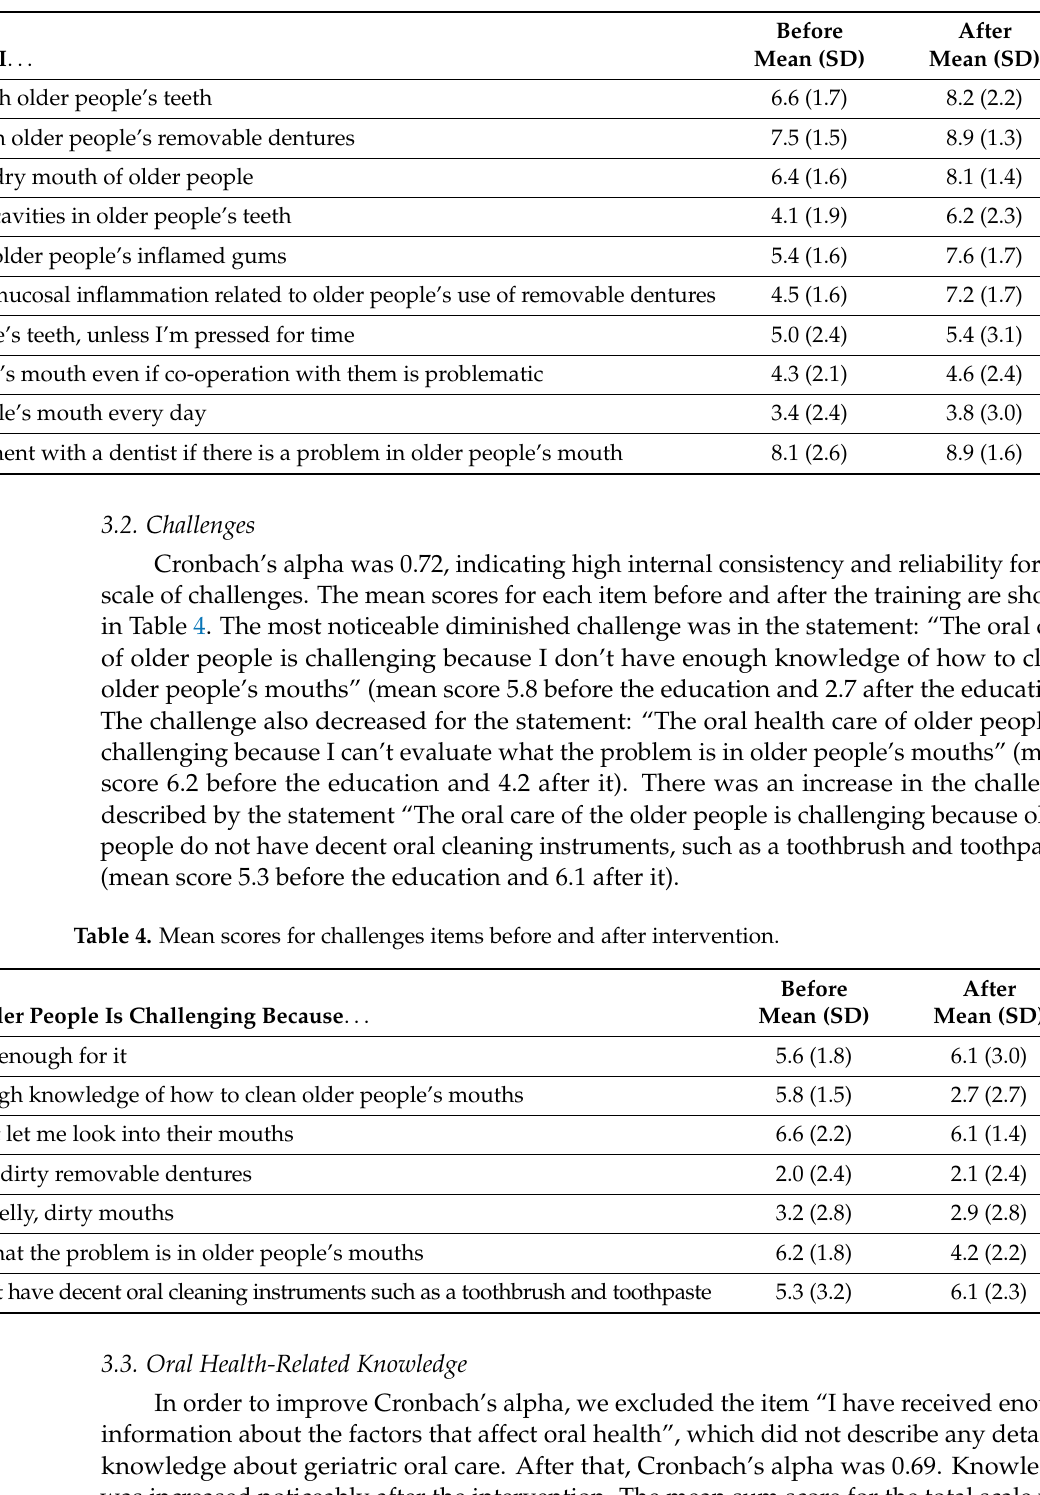
Table 3. Mean scores for the self-efficacy items before and after intervention.